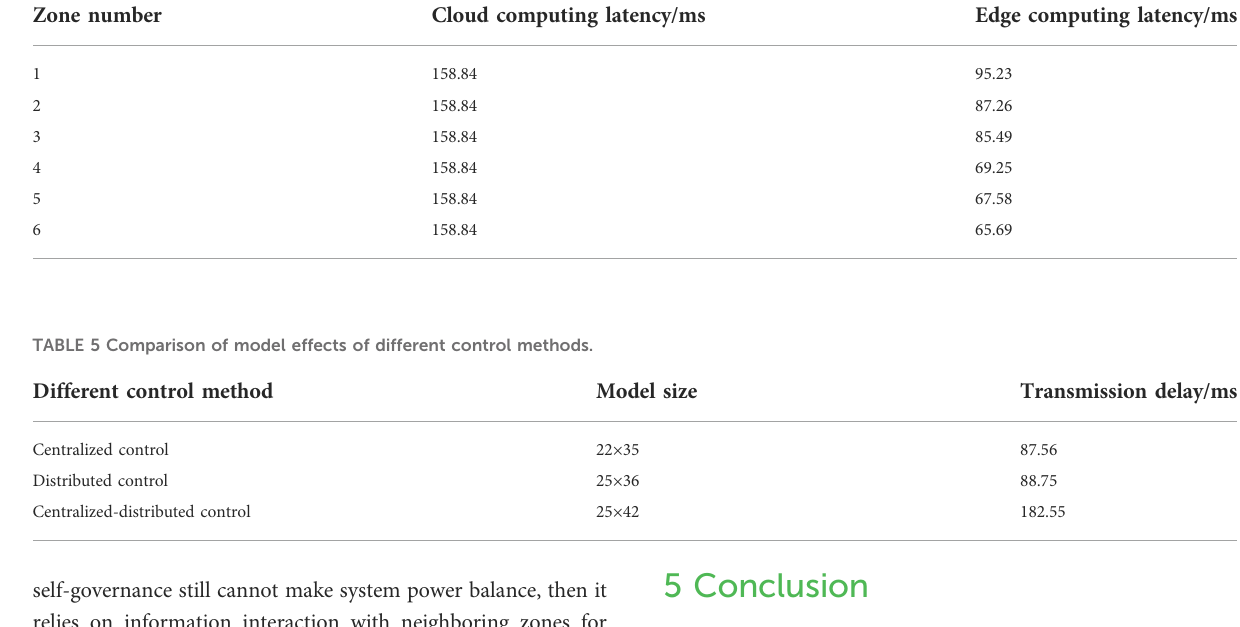
TABLE 4 Transmission characteristics of information branch.